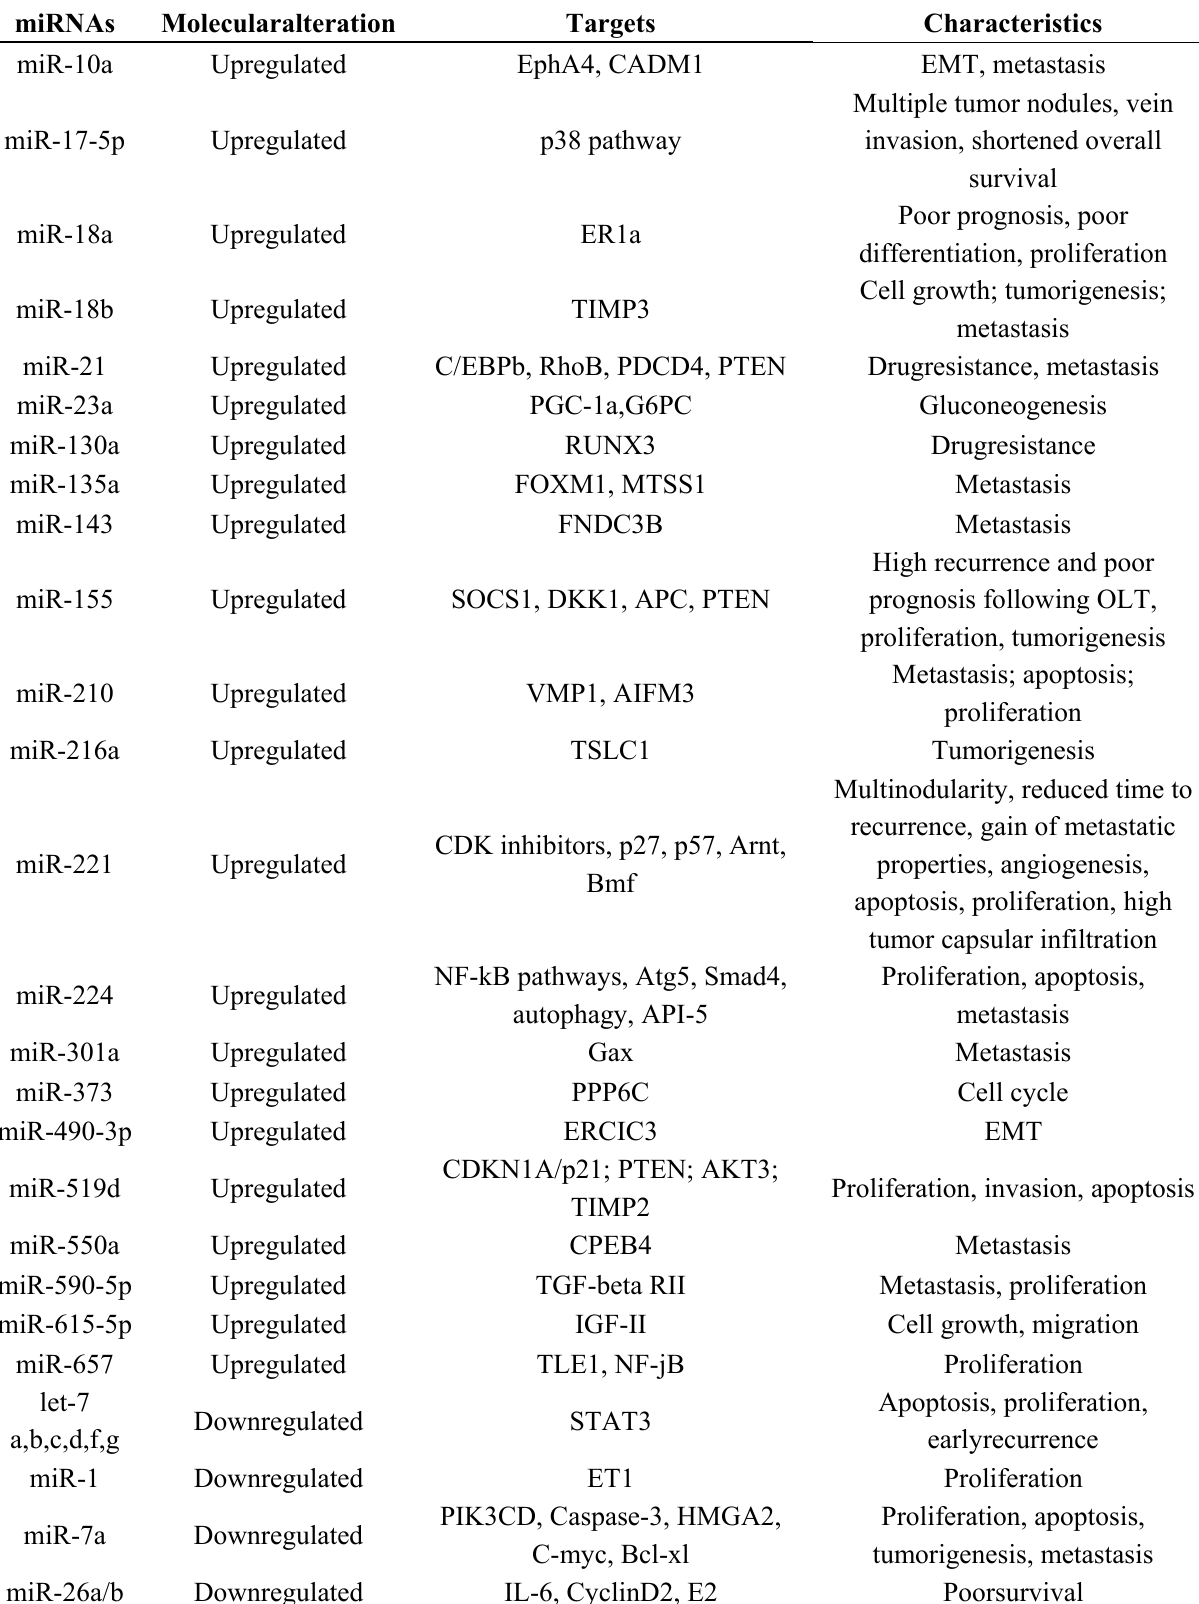
Table 1. miRNAs deregulated in hepatocellular carcinoma